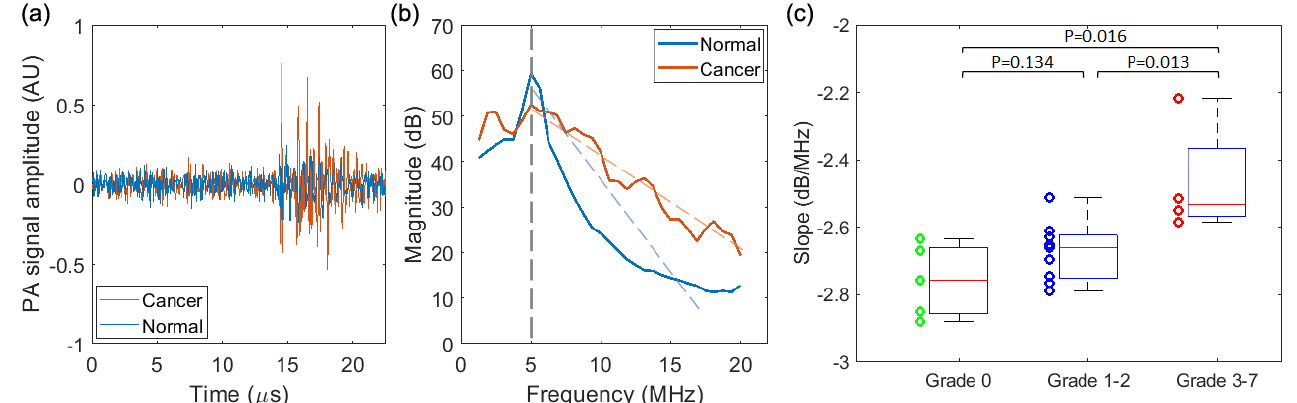
Figure 7. PASA results from the prostates of 18 TRAMP mice acquired by the PA–US dual imaging system. ( a ) PA signals from a cancerous prostate and a normal prostate. ( b ) Power spectra of the PA signals from the cancerous prostate and the normal prostate. ( c ) Quantified spectral parameter slopes of the prostates categorized in three groups, including Grade 0, Grades 1–2, and Grades 3–7, based on pathological evaluation. Two–tailed t -tests between the groups were performed, and those with statistically significant differences are marked in ( c ).